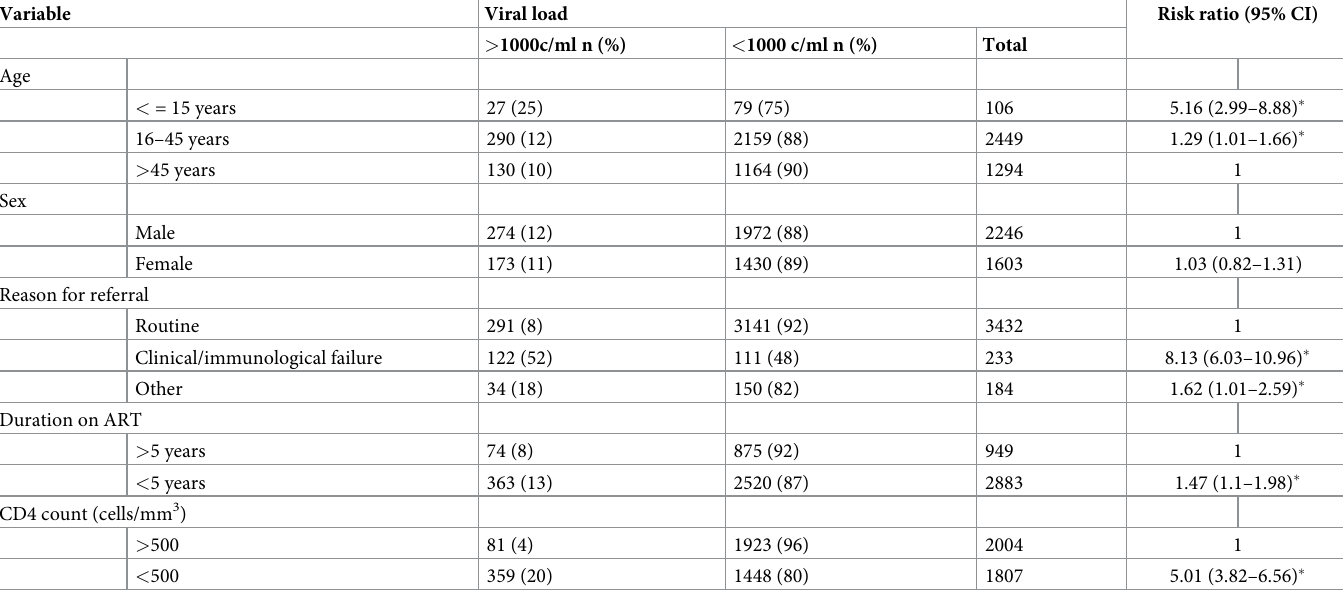
Table 3. Factors affecting initial VL among patients on ART at KEM hospital,